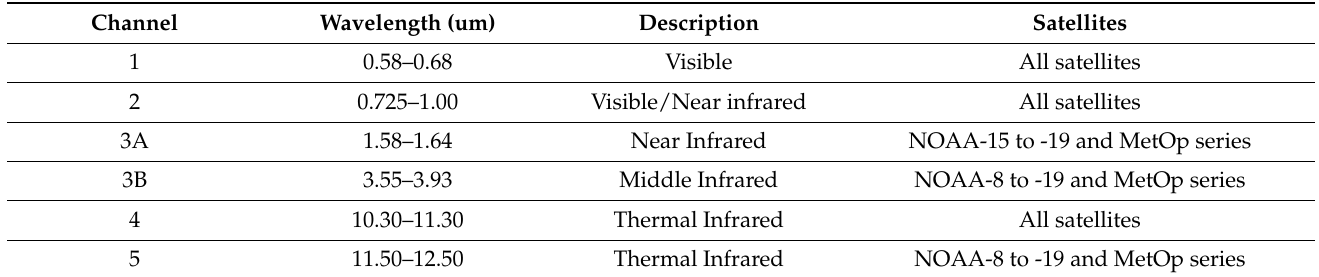
Table 2. AVHRR specifications for NOAA and METOP satellites. Categories are AVHRR/3 (all chan- nels), AVHRR/2 (minus Channel 3A) and AVHRR/1 (minus Channel 3A and Channel 5).